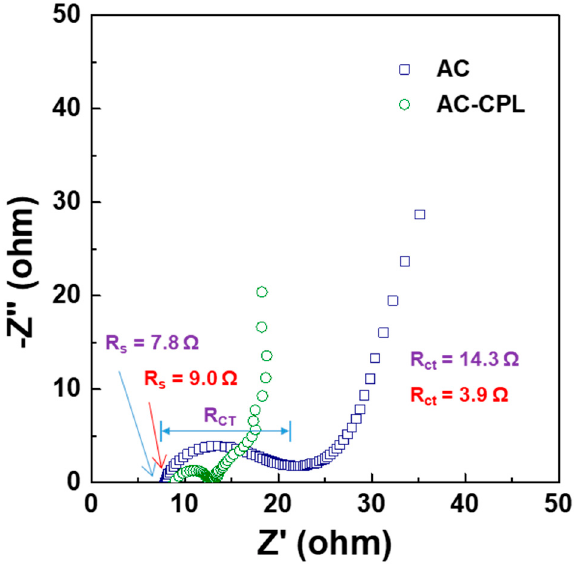
Figure 4. Nyquist plots of AC, and AC-CPL in 0.5 M CsNO 3 solution. (Color of navy: R s and R ct of the AC, color of olive: R s and R ct of the AC-CPL).